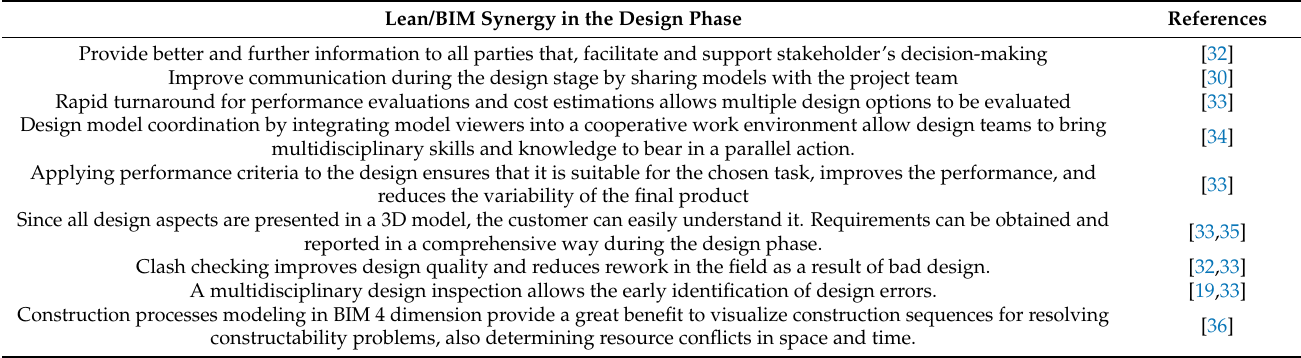
Table 2. Lean/BIM interactions during the design